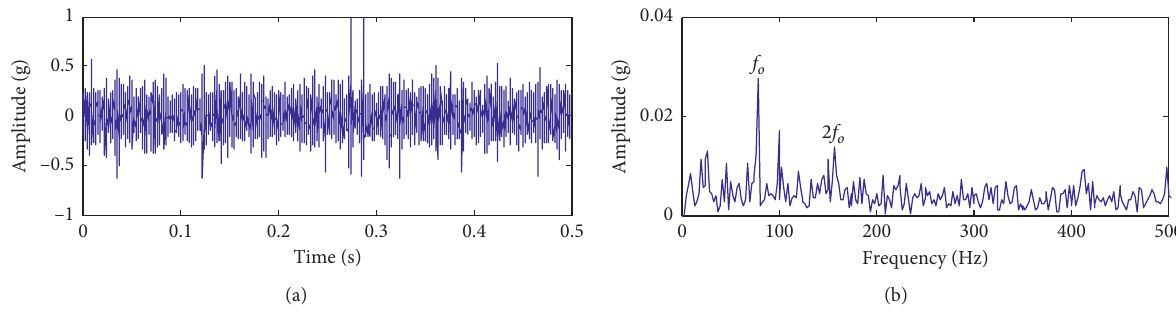
Figure 23: Comparison results of engineering signal by the MCKD method: (a) the waveform of deconvolution signal; (b) the envelope spectrum of deconvolution signal.